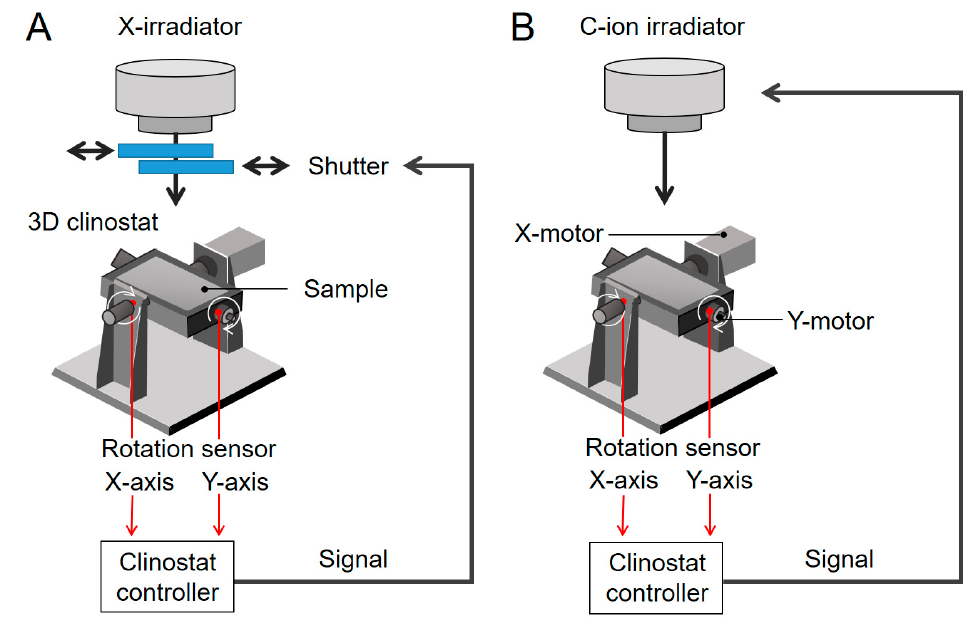
Figure 5. Schema of 3D clinostat synchronized irradiation systems for studying the combined effects of radiation and simulated μ G . For synchronization, X-ray irradiation using a high-speed shutter ( A ) and C-ion irradiation with a respiratory gating system as used in heavy ion radiotherapy were performed ( B